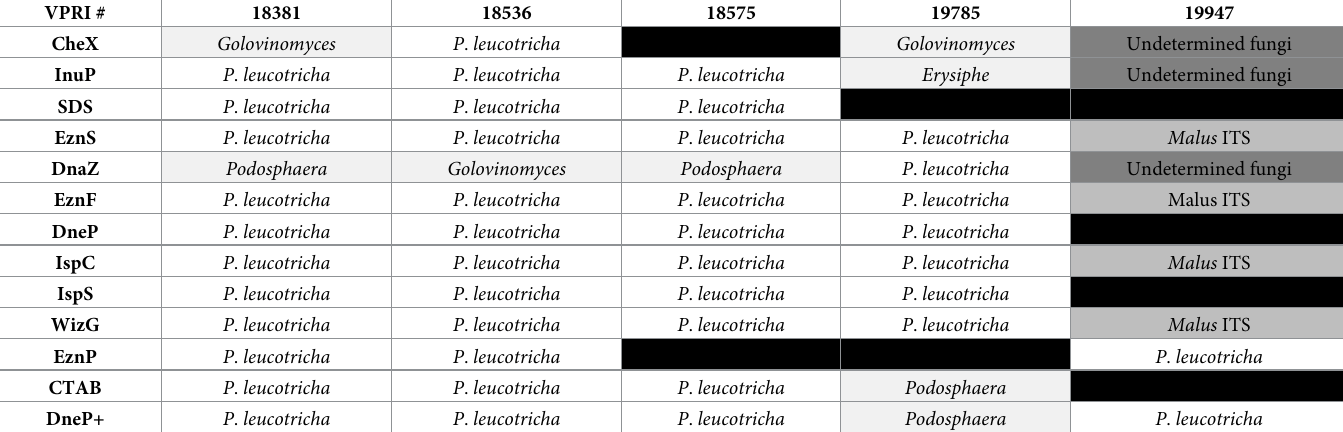
Table 4. Nested PMITS1/PMITS2 and PMITS1/ITS4 PCR results for VPRI apple powdery mildew P . leucotricha specimens.